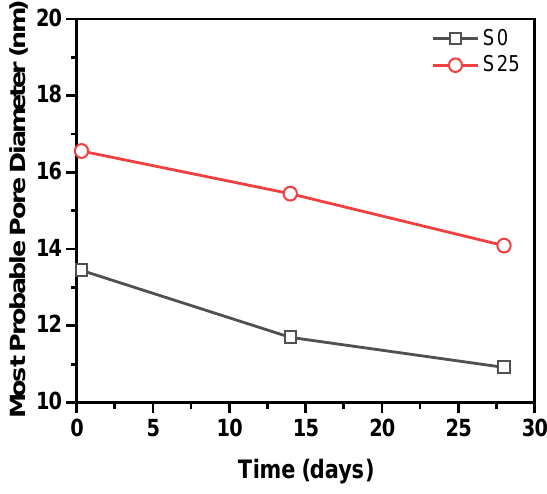
Figure 13. The most probable pore diameter of S0 and S25.